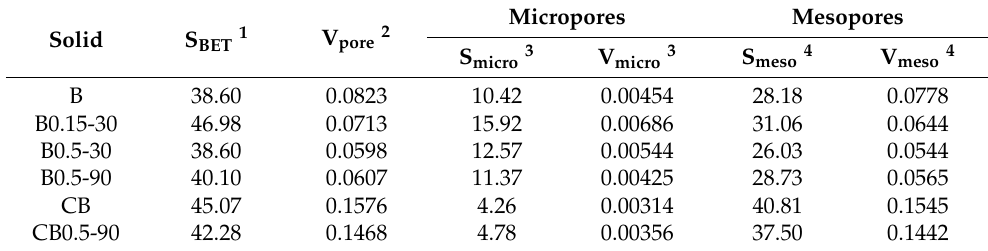
Table 1. Textural properties of the solids.